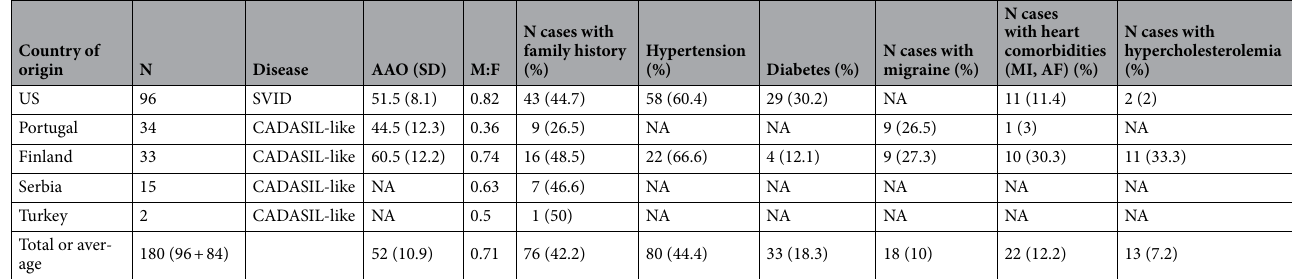
Table 1. SVID and CADASIL-like exome sequencing cohort. SVID small vessel ischemic disease, AAO age at onset, SD standard deviation, M male, F female, MI myocardial infarction, AF atrial